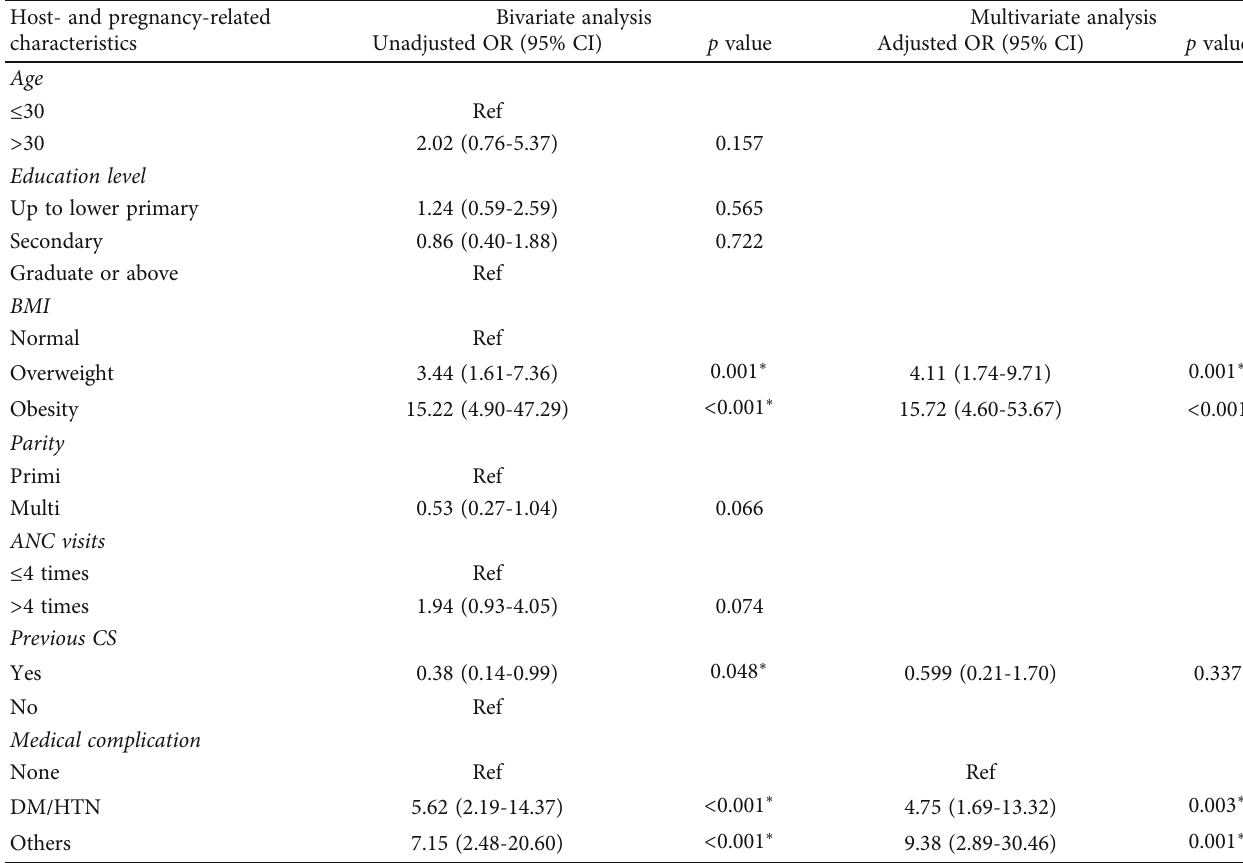
Table 3: Bivariate and multivariate logistic regression model for host- and pregnancy-related risk